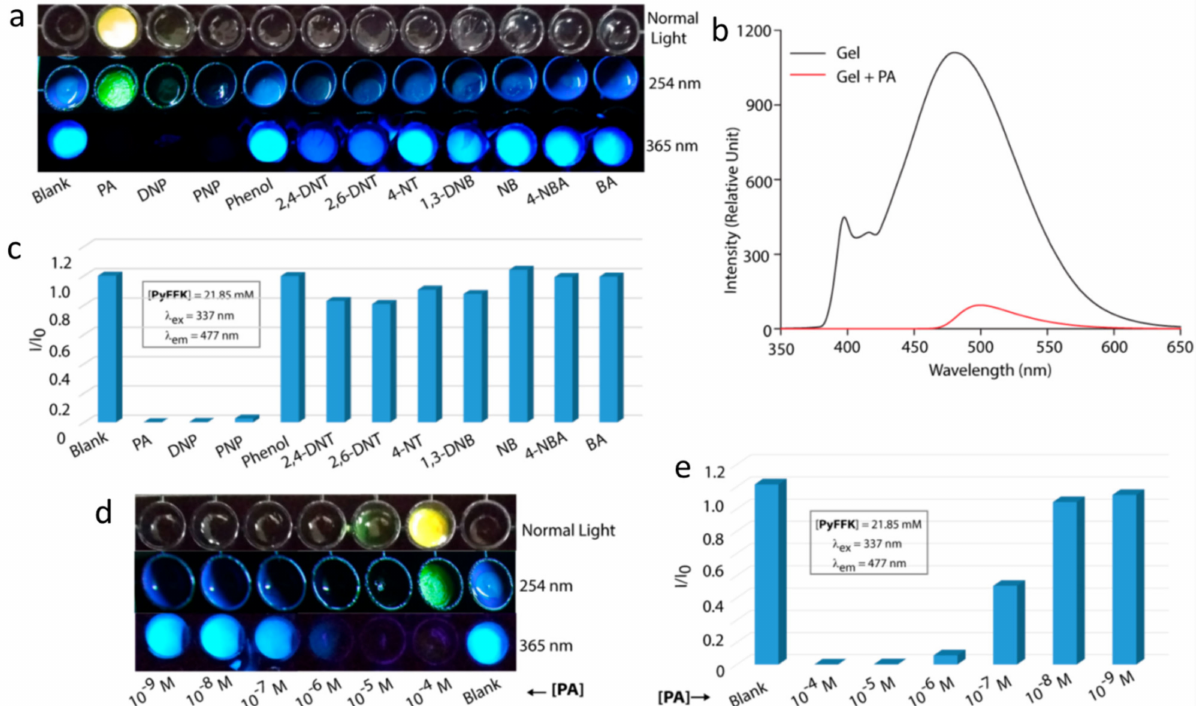
Figure 8. ( a ) Photographs of PyFFK gel-loaded wells of a multiwell plate in the presence or absence of different analytes under different lights. ( b ) Emission spectra of a gel sample in before and after treatment with picric acid (PA) solution ( λ ex = 337 nm). ( c ) The extent of quenching of the 477 nm band in the emission spectra of the gel samples in the presence of different analyte solutions. ( d ) Photographs of PyFFK gel-loaded wells of a multiwell plate after treatment with solutions of different concentrations of PA under different lighting conditions. ( e ) Extent of quenching of the emission at 477 nm for samples in ( d ). All experiments were performed at room temperature. Reprinted (adapted) with permission from [63]. Copyright (2019) American Chemical